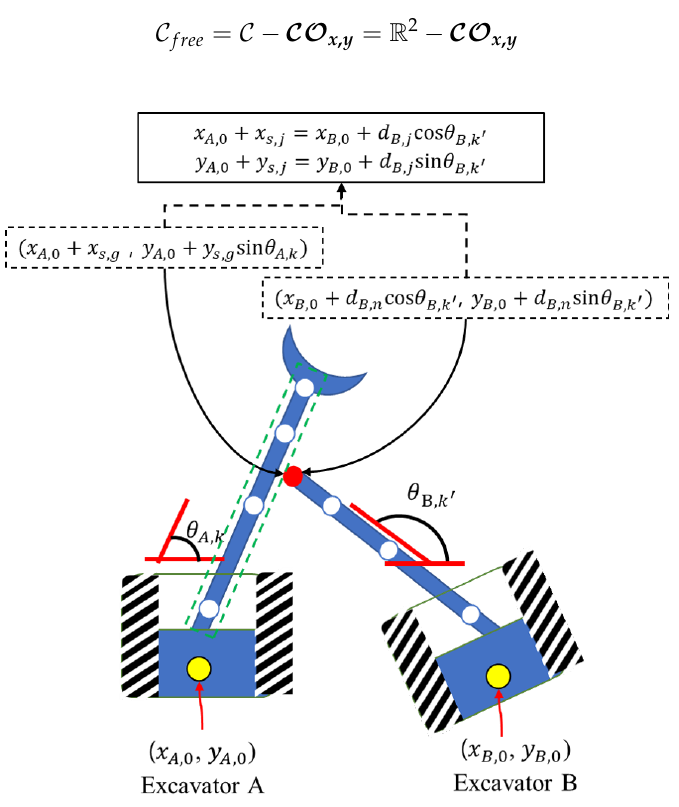
Figure 4. The end-point of Excavator B is contacting a specific point of Excavator A. 0 < k , k (cid:48) < m , and 0 < g < n are chosen as specific numbers representing this